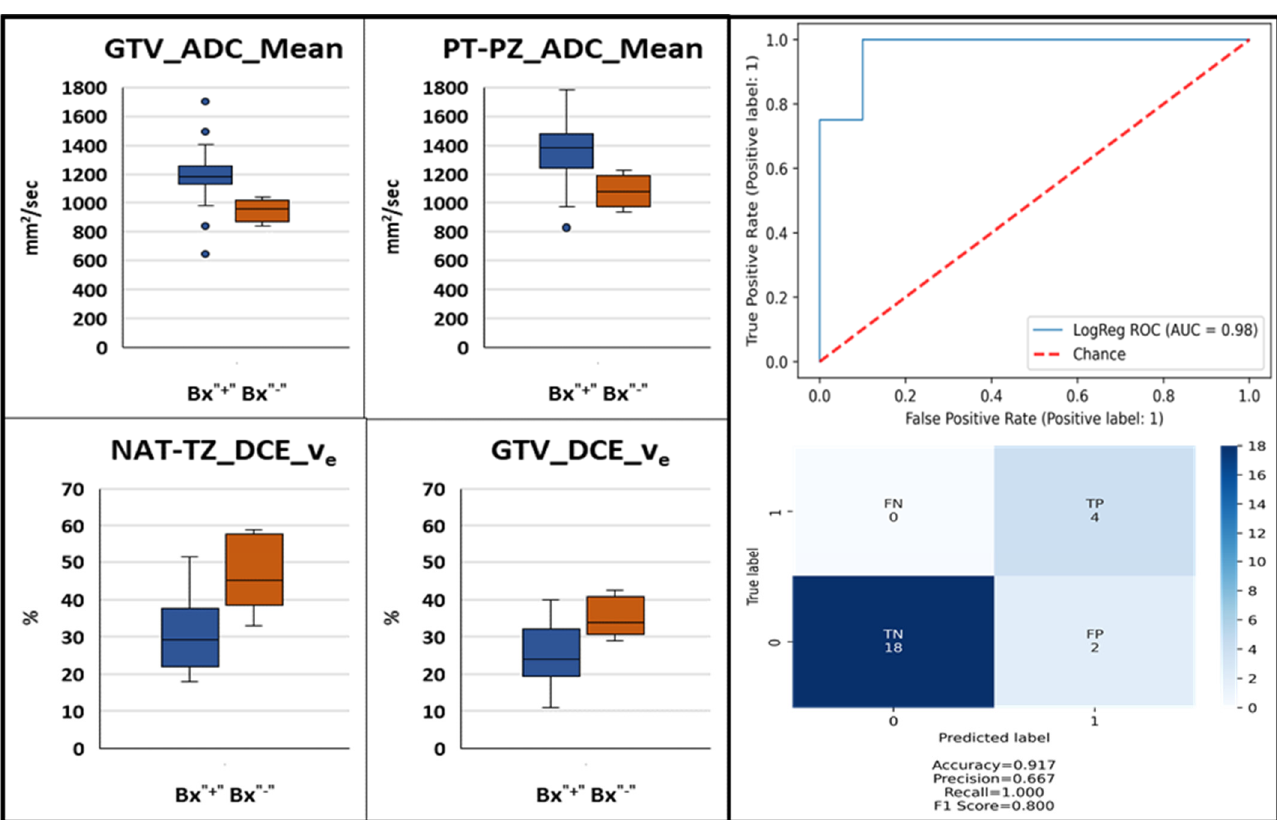
Figure 6. Baseline mpMRI-based model for the prediction of second year post-RT biopsy positivity. Box and whisker plots identified significantly different ( p -value < 0.05) quantitative ADC and DCE imaging features between patients with negative and positive second year biopsy ( left ). Receiver operating characteristic curve of a logistic regression model built using these baseline features and confusion matrix ( right ).